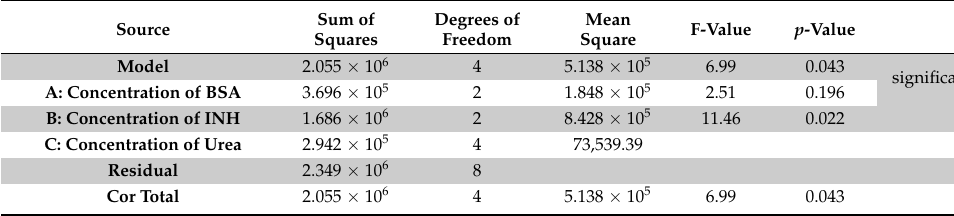
Table 5. ANOVA table for the encapsulation efficiency.